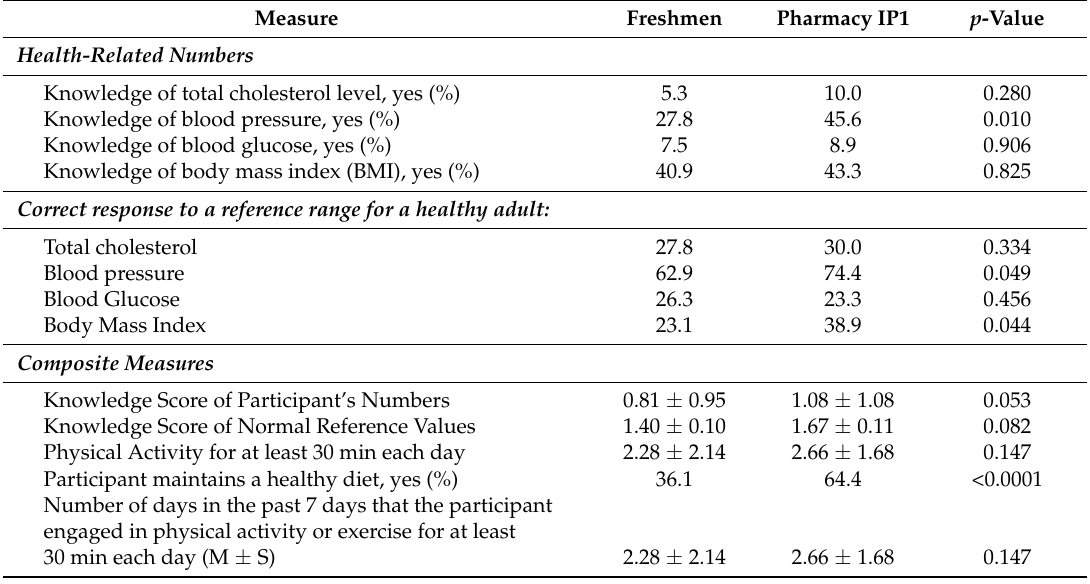
Table 2. Comparative analysis of key outcome measures of knowing your